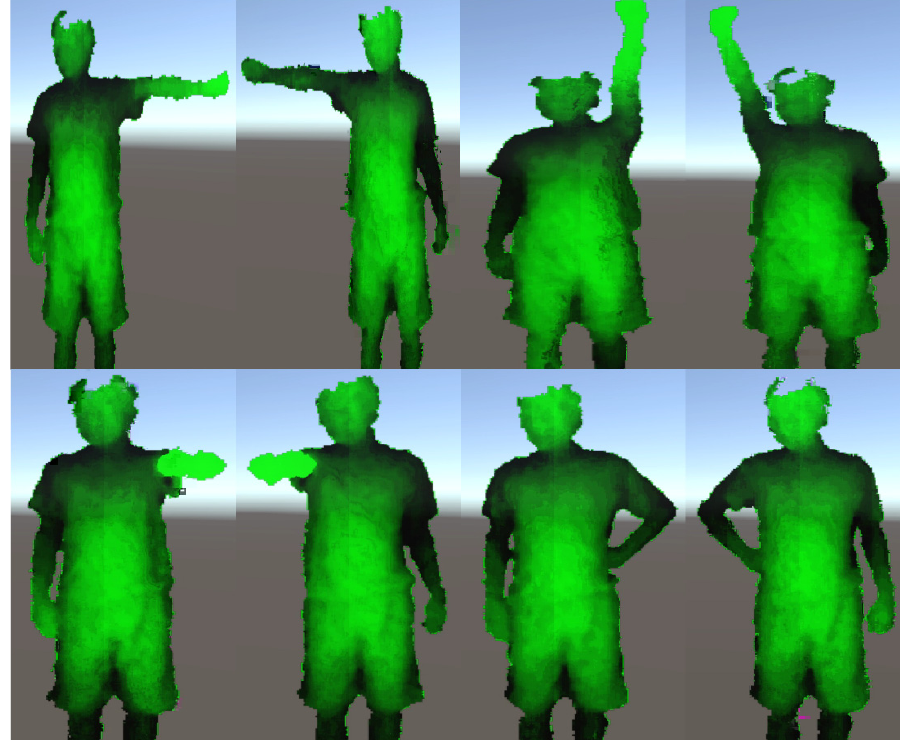
Figure 12. Eight gestures configured for Kinect sensor in this